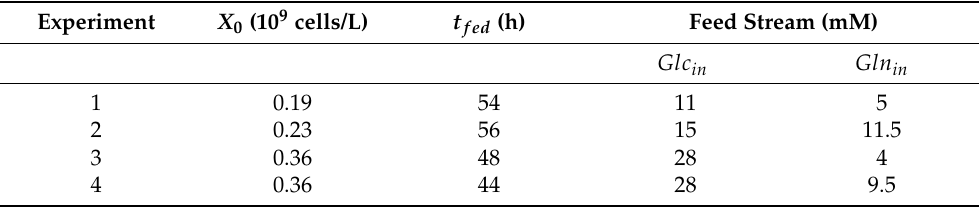
Table 1. Summary of culture conditions for experiments in